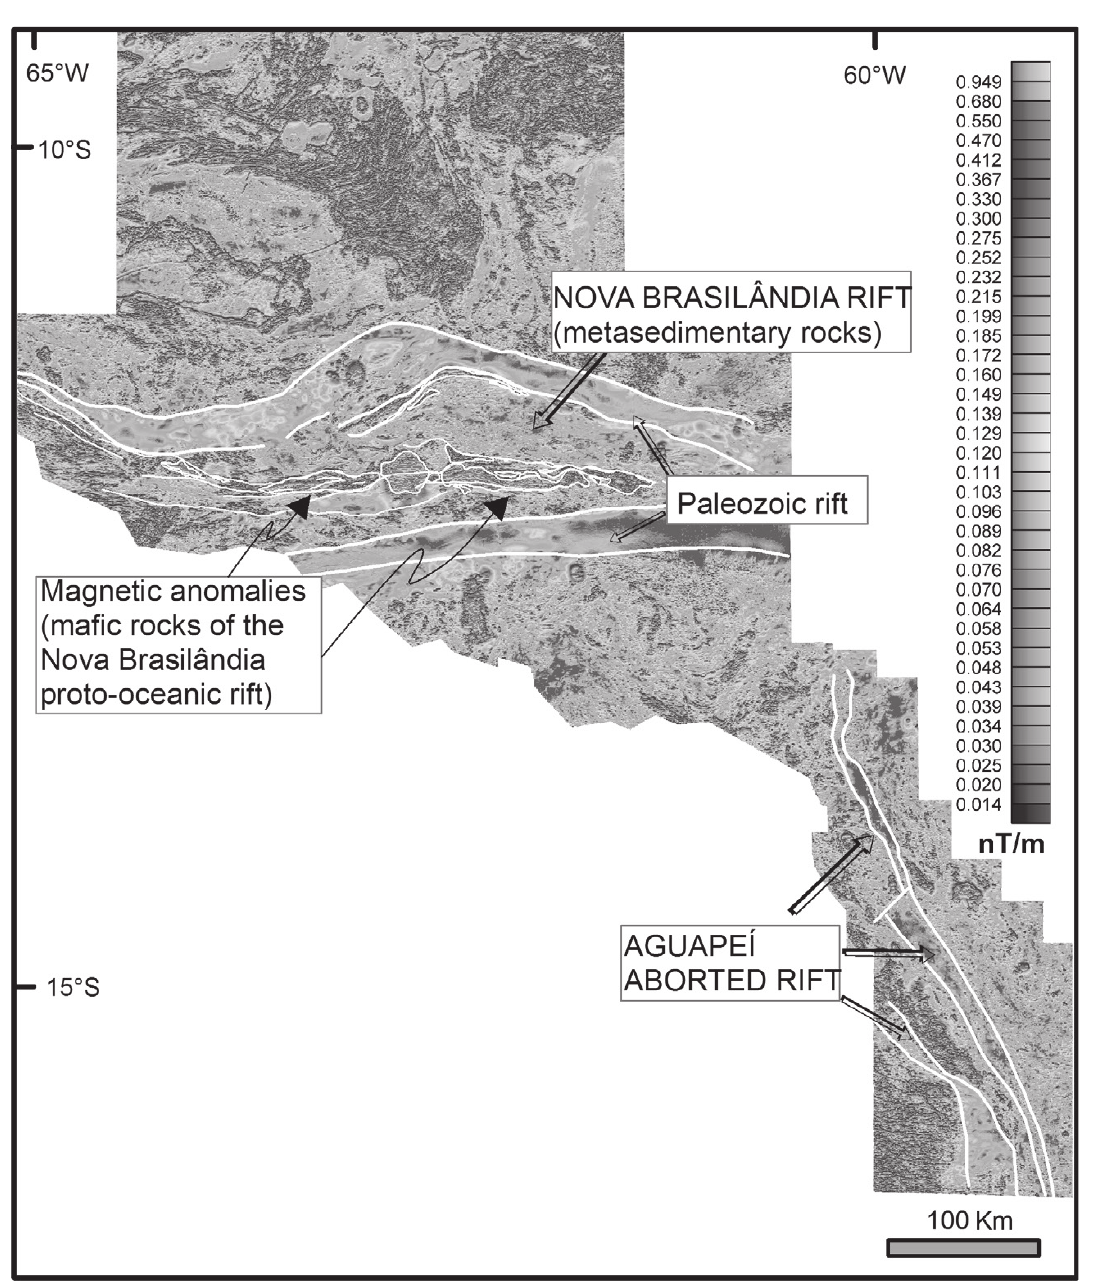
Figure 3 - Magnetometric data (analytical signal amplitude map) of southwestern margin of the Amazonian craton. The highlighted (white line) magnetic lineaments indicate the rift zones and areas with mafic rocks outcrops of the Nova Brasilândia proto-oceanic rift